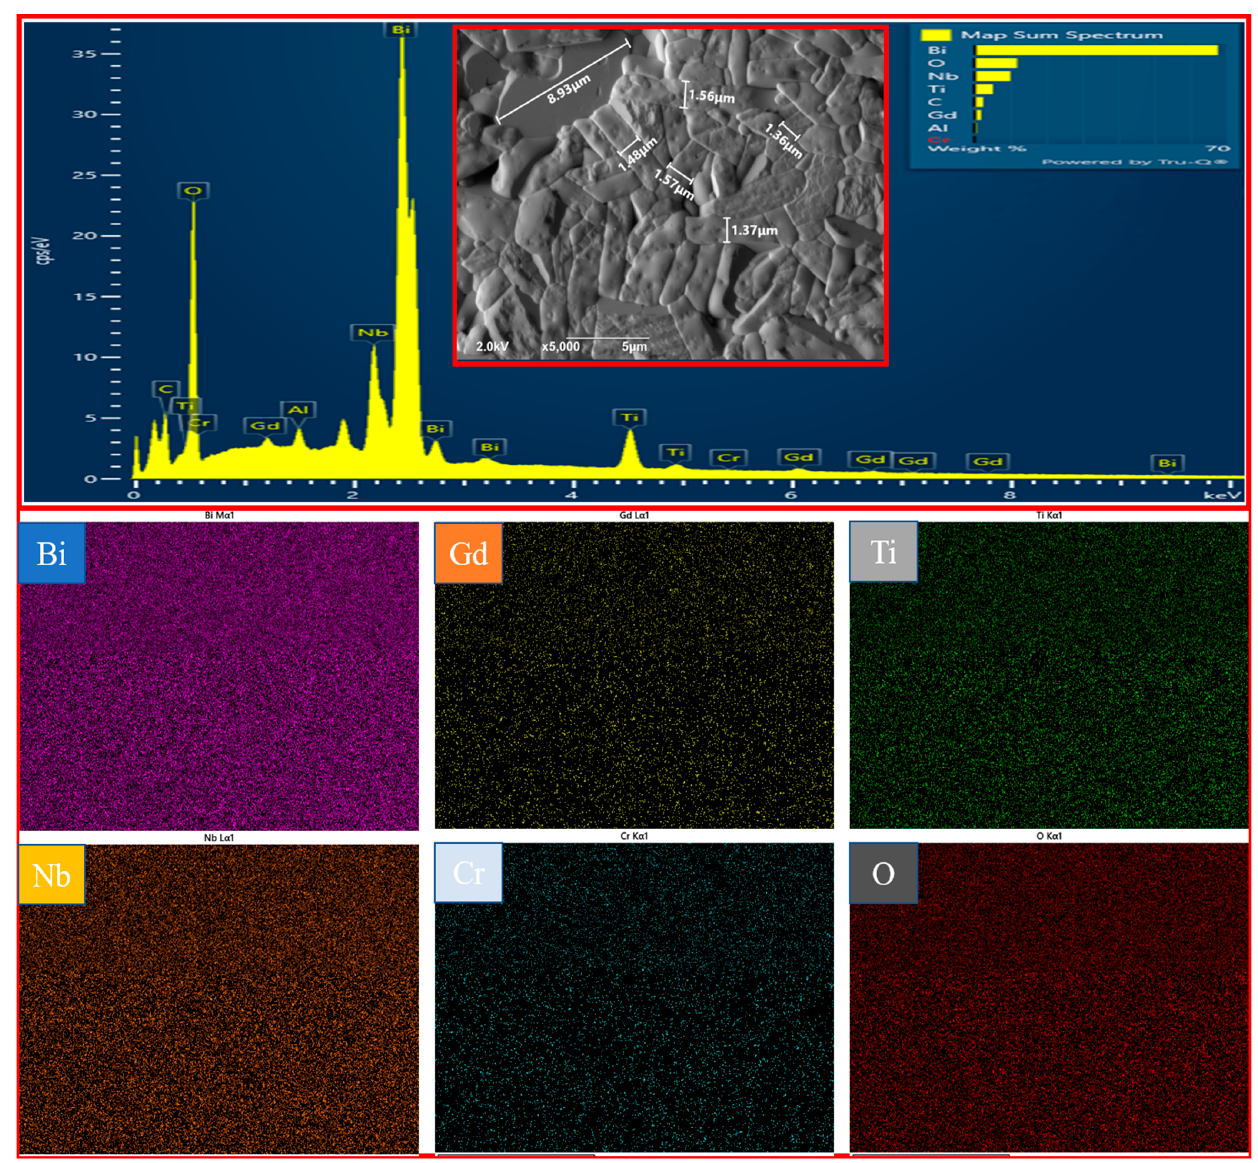
Figure 2. SEM and EDS analysis of the BGTN − 0.2Cr ceramic, focused on its thermal-etched surface (the grain size was determined using the intercept procedure on the basis of the SEM image).